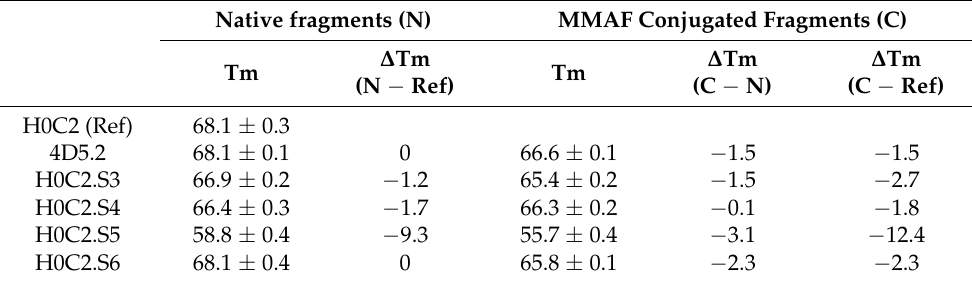
Table 2. Thermal stability of the native fragments H0C2, 4D5.2 and H0C2.Sx (x = 3 to 6), and conjugated fragments 4D5.2-MMAF and H0C2.Sx-MMAF (x = 3 to 6). Tm: melting temperature (corresponding to 50% of unfolded protein); Δ Tm and Δ Tm ( C − Ref ): variation of Tm in comparison to the reference frag- ment H0C2; Δ Tm ( C − N ): variation of Tm between a conjugated fragment and its native precursor.